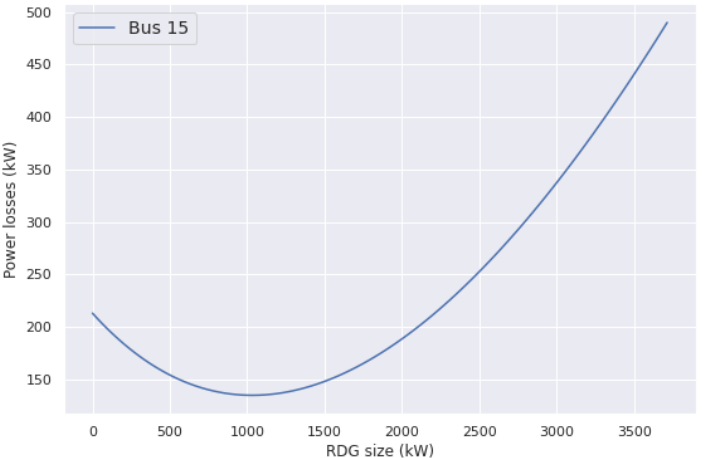
Figure 7. Variation of power losses with a single RDG for the IEEE 33-bus test distribution